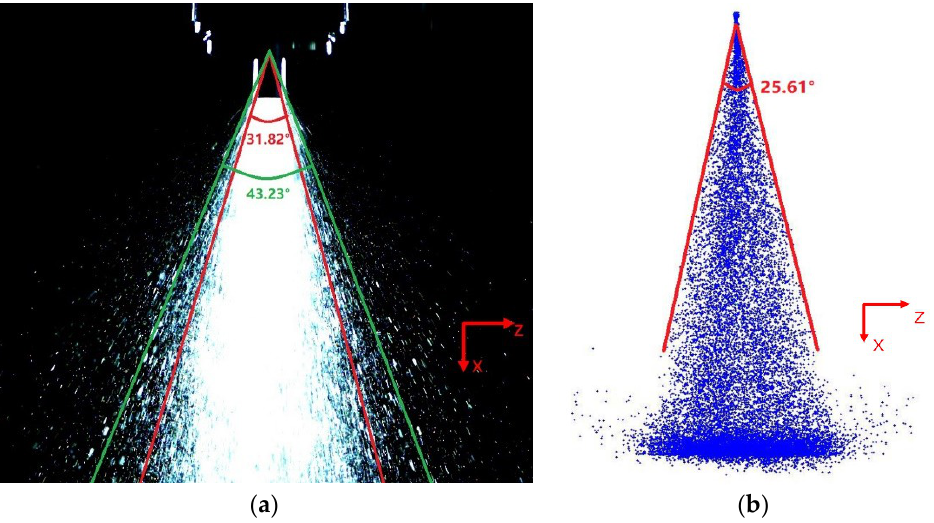
Figure 8. Spray cone angle of the atomization pattern in the flow field (Δ = 7.3): ( a ) experiment; ( b ) simulation.